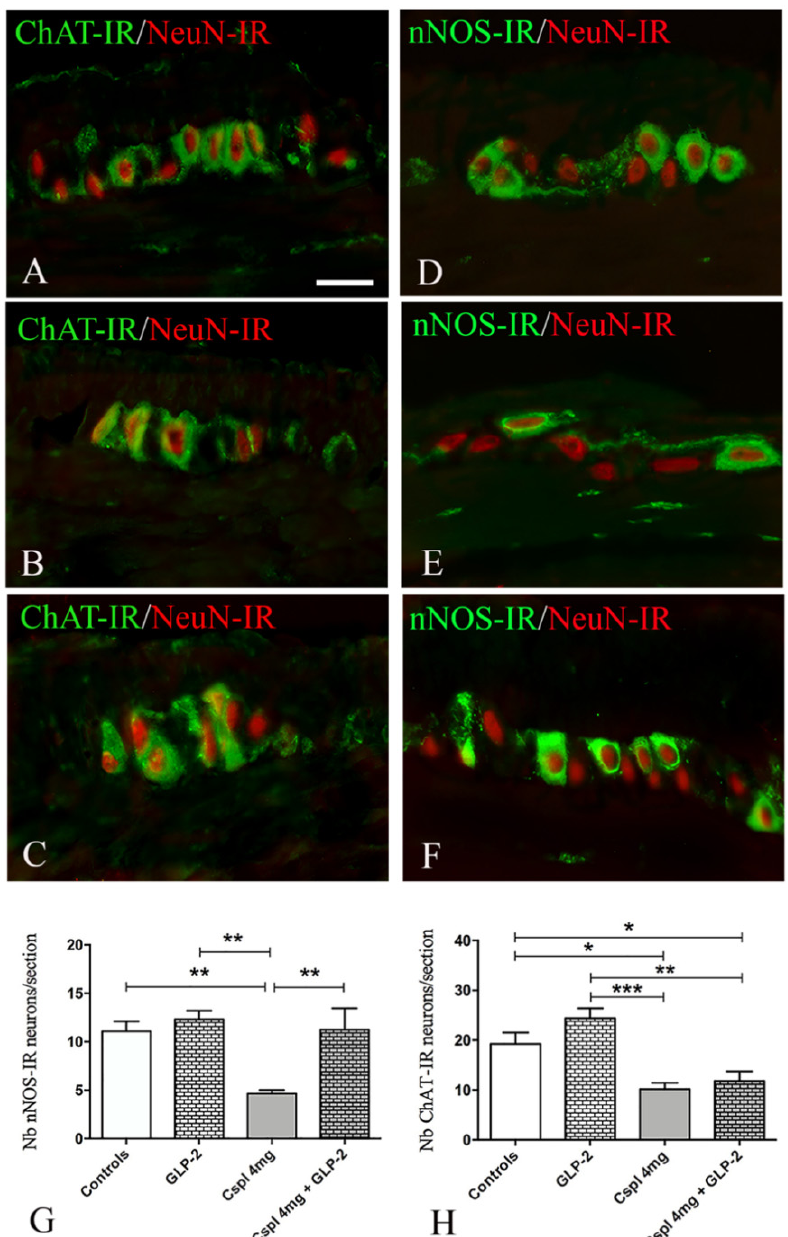
Figure 7. ChAT / NeuN ( A – C ) and nNOS / NeuN ( D – F ) double labeling in myenteric ganglia. Controls ( A , D ), cisplatin ( B , E ) and cisplatin + [Gly2]GLP-2 ( C , F ) groups. ChAT and nNOS labeling were detected mainly in the neuronal body and in few nerve fibers; NeuN-IR was always observed in the nucleus. Scale bar = 25 µ m. Quantitation of the nitrergic and cholinergic neurons number ( G , H ). Data are expressed as mean ± SEM. One-way ANOVA test, post hoc Newman Keuls’. *** ( p < 0.001), ** ( p < 0.01), * ( p < 0.05). n = 4–6 for each group.